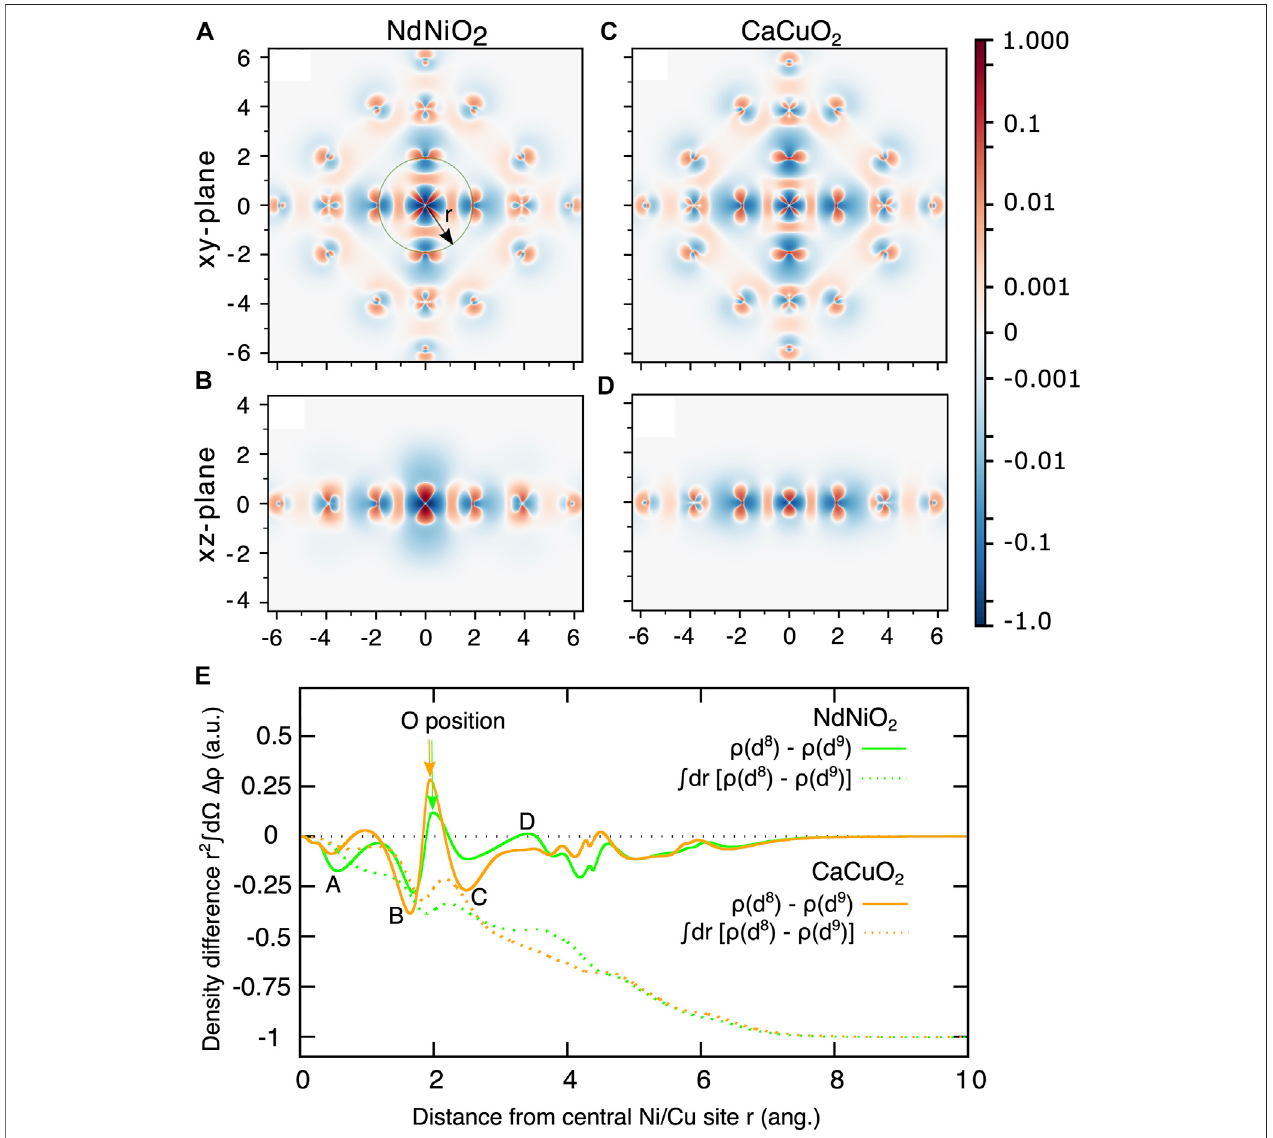
FIGURE 3 | Electron density difference of the d 8 and d 9 ground states ( ρ ( d 8 ) − ρ ( d 9 )) for NdNiO 2 in the xy-plane (A) and xz-plane (B) , and for CaCuO 2 xy-plane (C) andxz-plane (D) .ThecoordinatesofthecentralNi(Cu) d 8 ionaresetto(0,0).Thescaleoftheheat-barislogarithmicbetween±0.001to±1.0andislinearbetween0and ±0.001. (E) ElectrondensitydifferenceintegratedoveraspherecenteredonthecentralNi(Cu)atoms(fullcurves)asafunctionoftheradius r shownin (A) .Theresultofan additional radial integration (dashed curves) as a function of the upper integration limit.